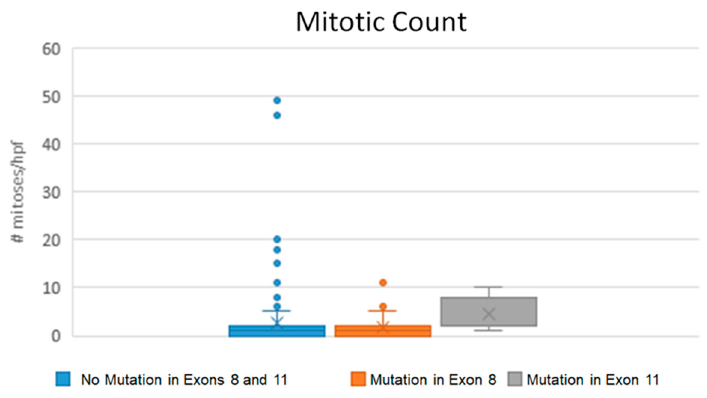
Figure 2. Boxplot of mitotic count per 10 high-power fields in subcutaneous mast cell tumors with different mutation status. Internal tandem duplication mutations in exon 11 (gray) were significantly associated with a higher mitotic count compared to exon 8 (orange) mutations ( p = 0.001) and no (blue) mutations ( p < 0.001), but there was no difference between the latter two groups. There were no statistically significant differences in proliferation markers (Ki67 index, AgNOR count, AgNOR x Ki67 index) or in KIT protein localization patterns in subcuta- neous MCTs with mutations in either exon 8 or exon 11 when compared to each other or to subcutaneous MCTs without exon 8 or 11 mutations (Figure 3). Of the high-grade subcutaneous MCTs, 23/43 (53.5%) had a Ki67 index of 23 or higher and a combined AgNOR x Ki67 index of 54 or higher. Only 19/173 (10.9%) low-grade subcutaneous MCTs had a Ki67 index of 23 or higher.